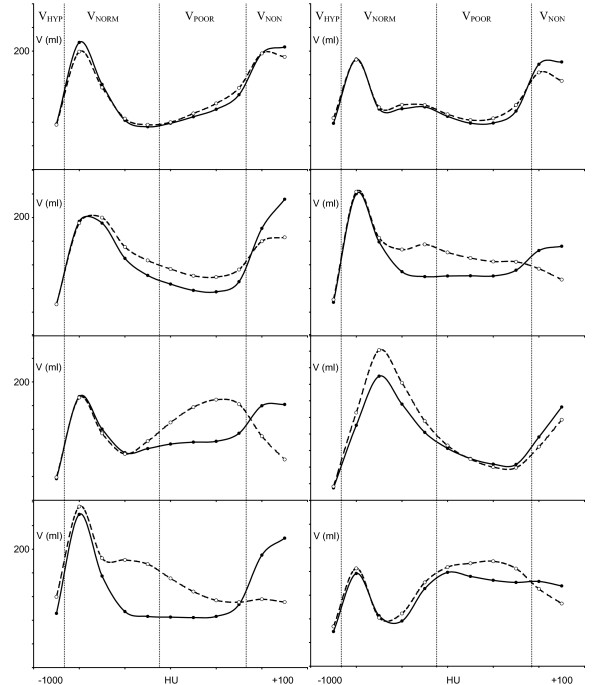
Distribution of differently aerated lung volumes. Individual curves for eight animals before (solid line) and after (dashed line) a recruitment maneuver. Multi-slice CT of the whole lung with characterization of lung parenchyma according to Hounsfield units at end-expiration. VHYP, volume of hyperinflated lung parenchyma; VNON, volume of nonaerated lung parenchyma; VNORM, volume of normally aerated lung parenchyma; VPOOR, volume of poorly aerated lung parenchyma.